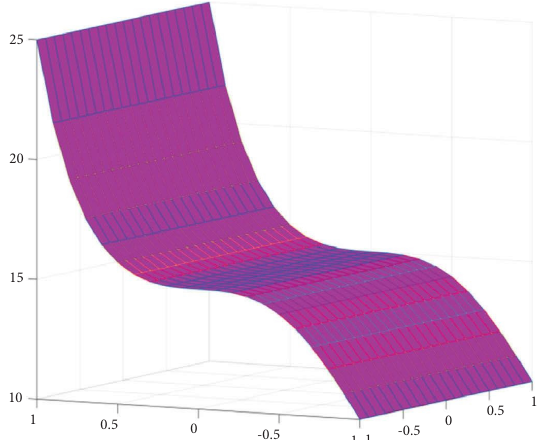
Figure 5: Te correlation of r and HM